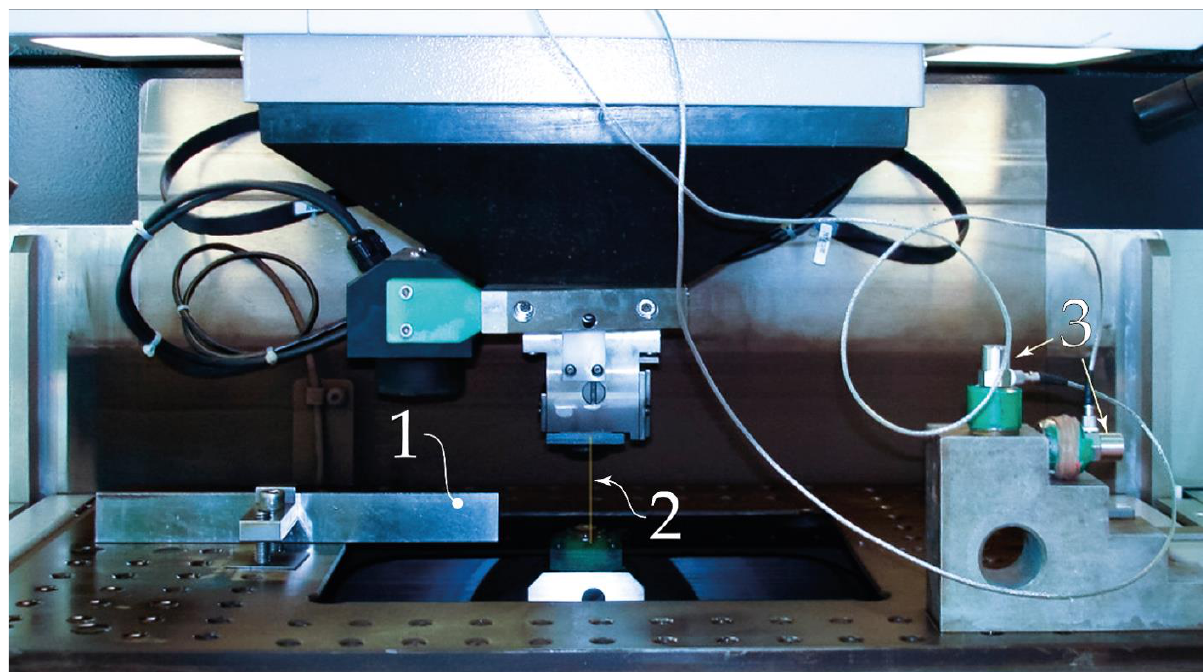
Figure 3. Working area of the Agie Charmilles CUT 1000 OilTech machine with installed accelerometers: 1 — electrode- workpiece; 2 — electrode- tool; 3 — accelerometer and acoustic emission sensors.